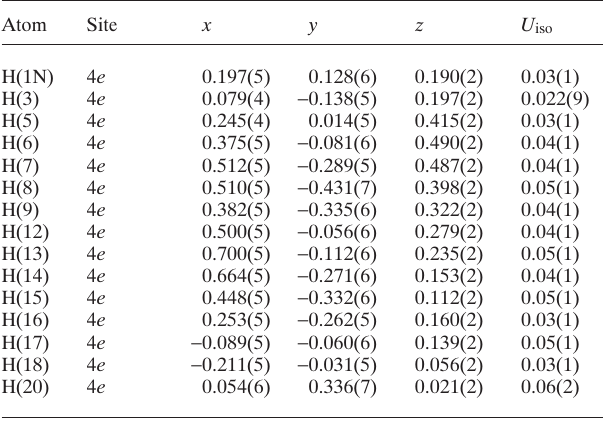
Table 2. Atomic coordinates and displacement parameters (in Å 2 )